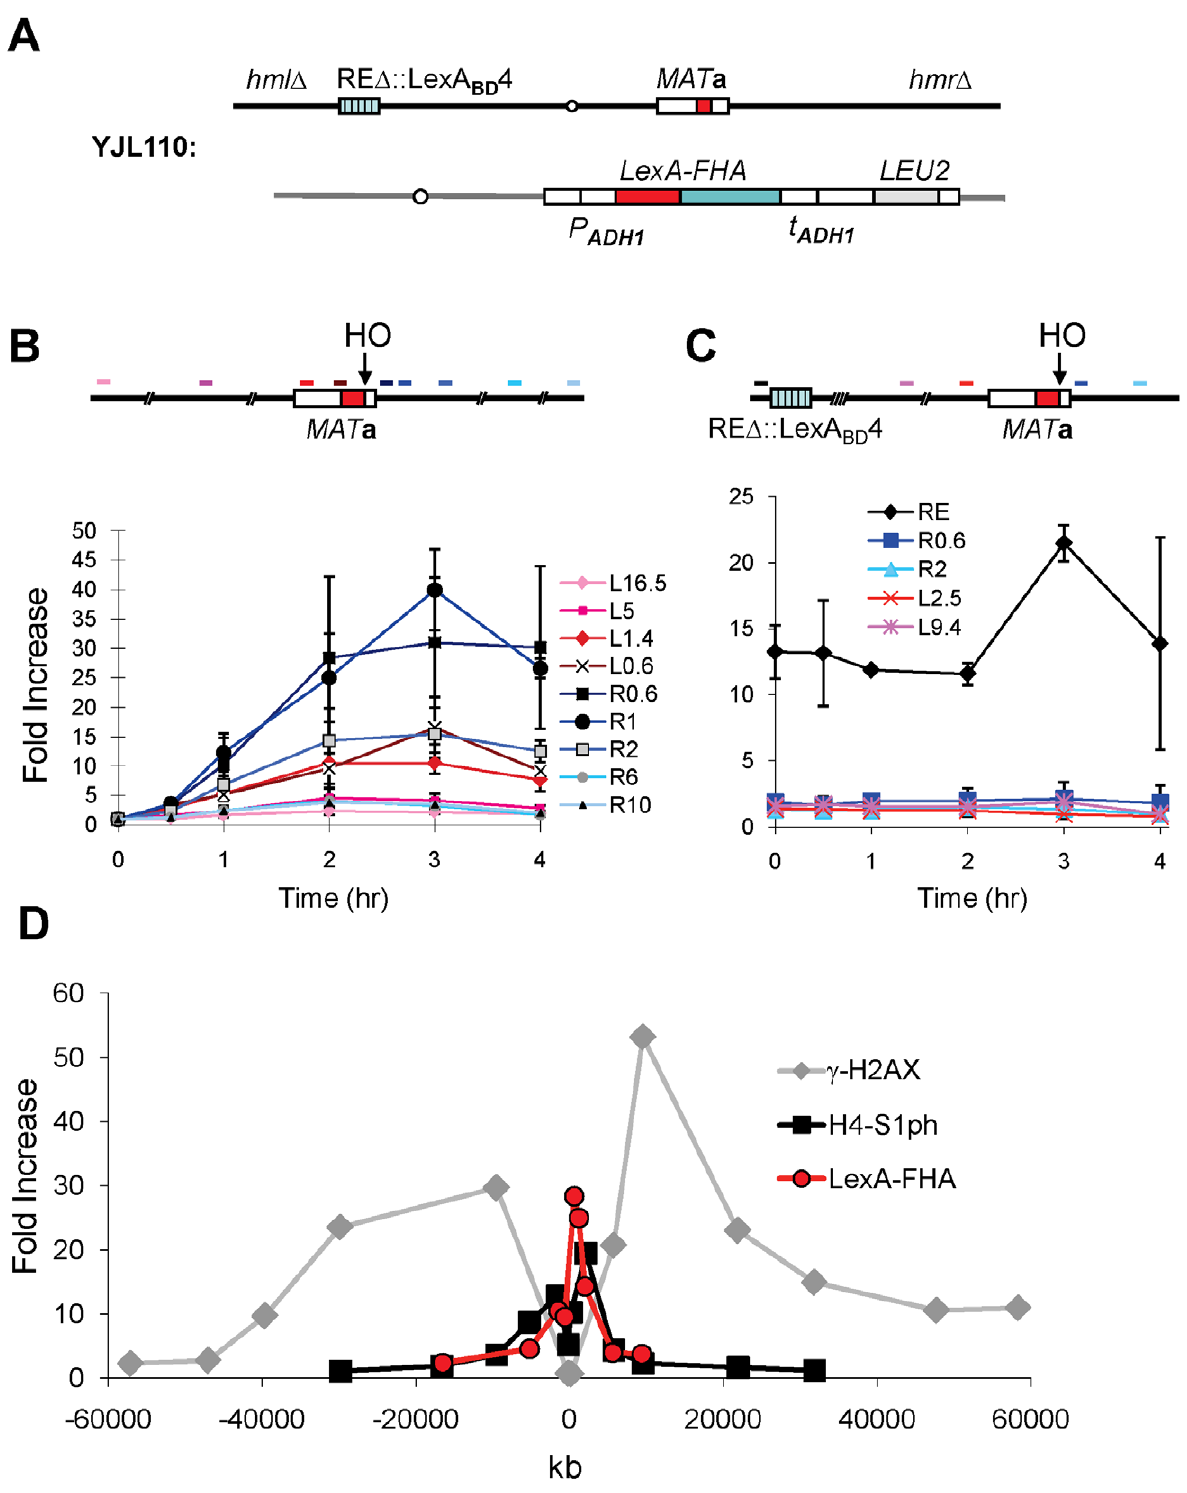
Figure 4. The FHA Domain of Fkh1 Physically Interacts with the MAT after DSB Induction. (A) Chromosome III and relevant strain genotypes for YJL110. This donorless strain is same as YJL019 (Figure 3A) except that HML and HMR are deleted. Both YJL019 and YJL110 have a wild- type Fkh1, which is not functional in donor preference because Fkh1 cannot bind to RE D ::LexA BD 4. (B) LexA-FHA fusion protein physically interacts with the MAT after DSB induction. YJL110 was grown in YP-galactose and subjected to ChIP using anti-LexA antibody. The primer pair L16.5 is 16.5-kb proximal (left) from the HO site of MAT a, whereas R10 is located 10-kb distally (right). All other primer pairs are named and color-coded accordingly. The approximate position of each primer pair is shown in the above diagram. Immunoprecipitation (IP) signals were quantified via real-time PCR, and IP signal at each locus was normalized to that of a control locus CEN8 . Y axis represents IP signal as fold increase relative to the IP signal at same locus before HO induction (time zero). Error bars are calculated from three repeated experiments. (C) The phosphothreonine binding motif of FHA domain